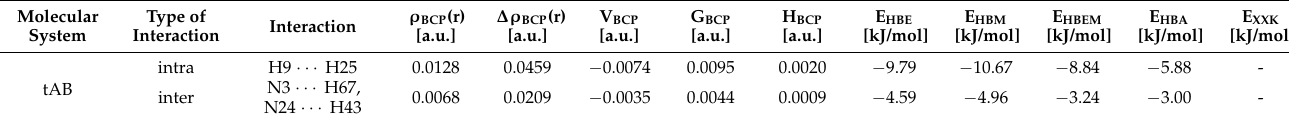
Table 8. Topological parameters of ρ (r) for the interactions in tIAB, tBrAB, tClAB and AB (electron density at bond critical point, BCP, ( ρ BCP (r)), its Laplacian ∆ ρ BCP (r), the potential electron energy